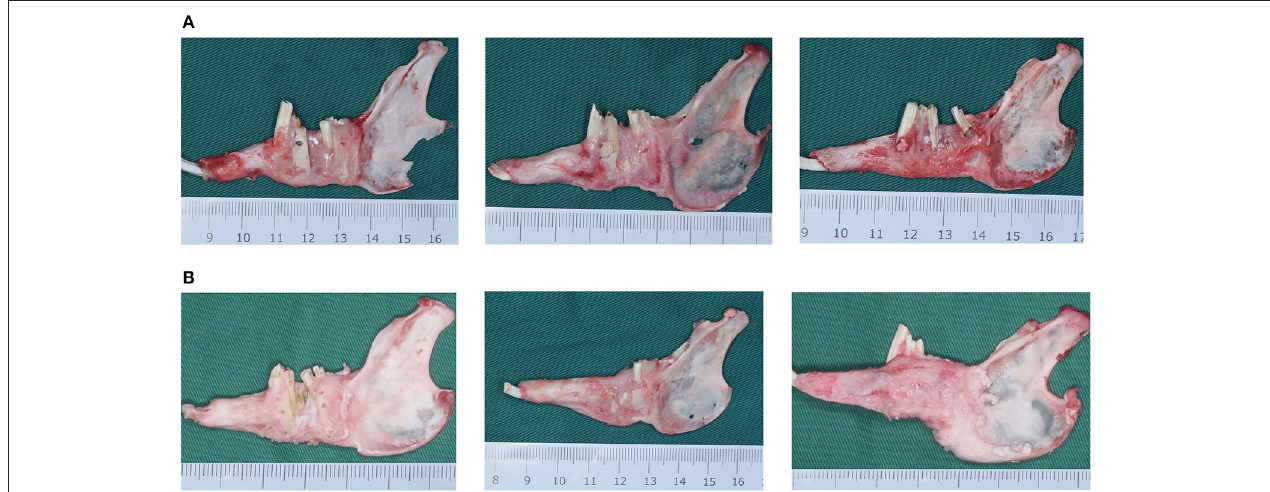
FIGURE 4 | (A) The mandibular gross specimens from the blank control (group A), the green fluorescent protein (GFP) (group B), and the bone morphogenetic protein 1 (BMP-1) (group C) at 3 weeks of fixation. (B) The mandibular gross specimens from the blank control (group A), the green fluorescent protein (GFP) (group B), and the bone morphogenetic protein 1 (BMP-1) (group C) at 6 weeks of